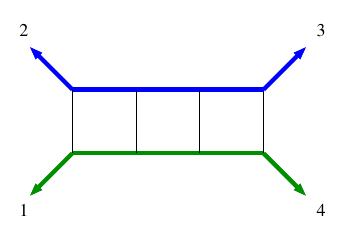
Figure 3 . Momentum routing for I ( a )